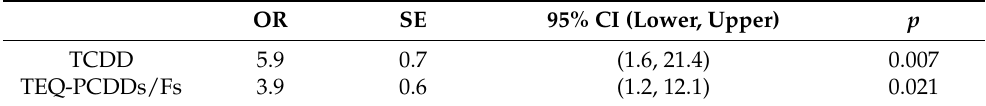
Table 4. Relationships between TCDD and TEQ-PCDD/Fs exposure and positive METAVIR scores (F2). OR